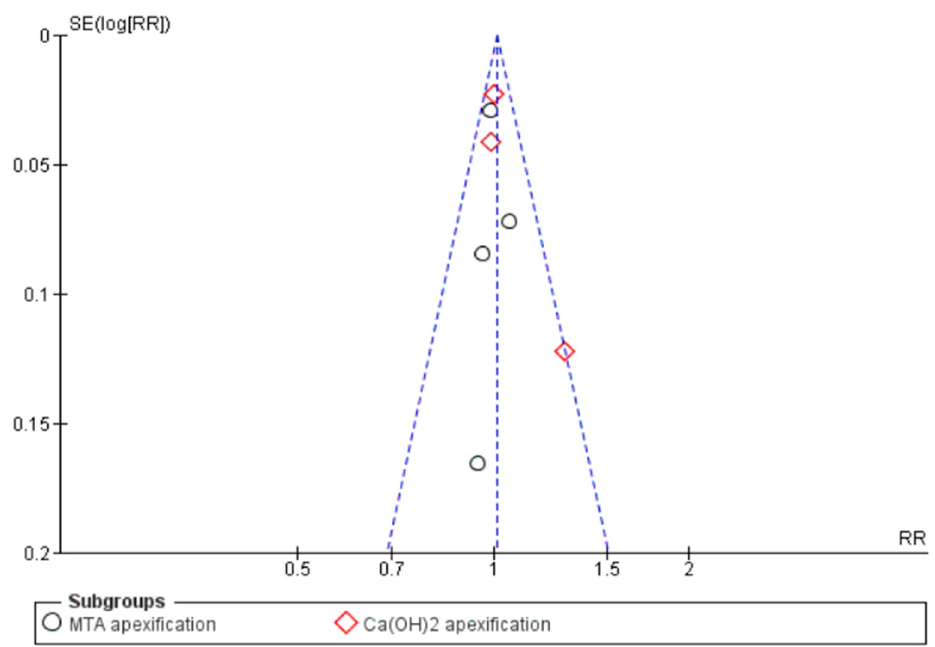
Figure 10. Funnel plot showing publication bias of studies on survival rate of young immature permanent teeth that underwent regenerative endodontic procedure (REP) or apexification